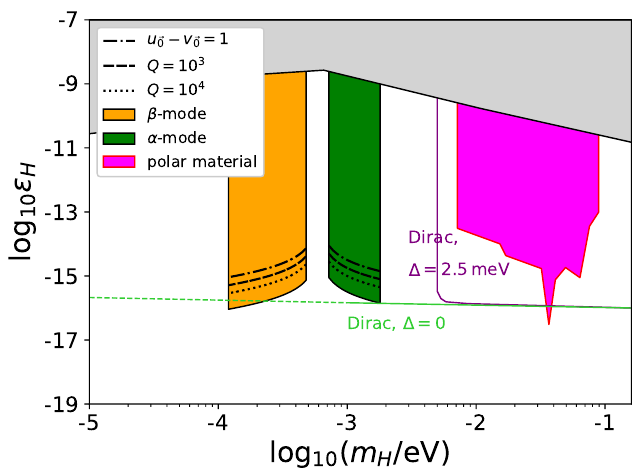
Figure 2 . Sensitivity of the magnon to the DM hidden photon in the m H vs. (cid:15) plane. The color and line style convention and the experimental set up are the same as those explained in figure 1. The gray region is a combination of existing constraints, while the magenta region shows a sensitivity of the polar material [73]. The purple and green lines correspond to the sensitivity of the Dirac material [74] with gap sizes ∆ = 2 . 5 meV and 0 ,